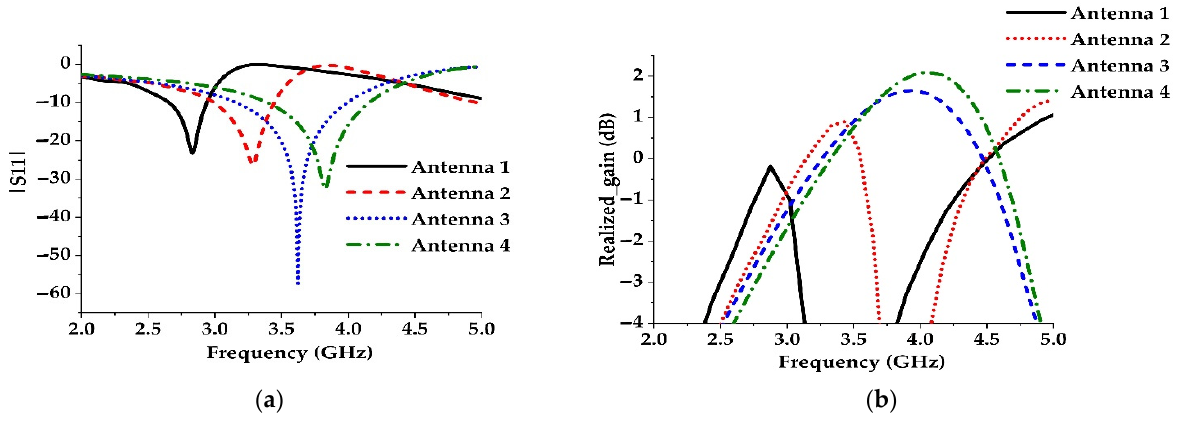
Figure 8. ( a ) Comparison of S-parameters of the antennas. ( b ) Comparison of gains of the antennas.